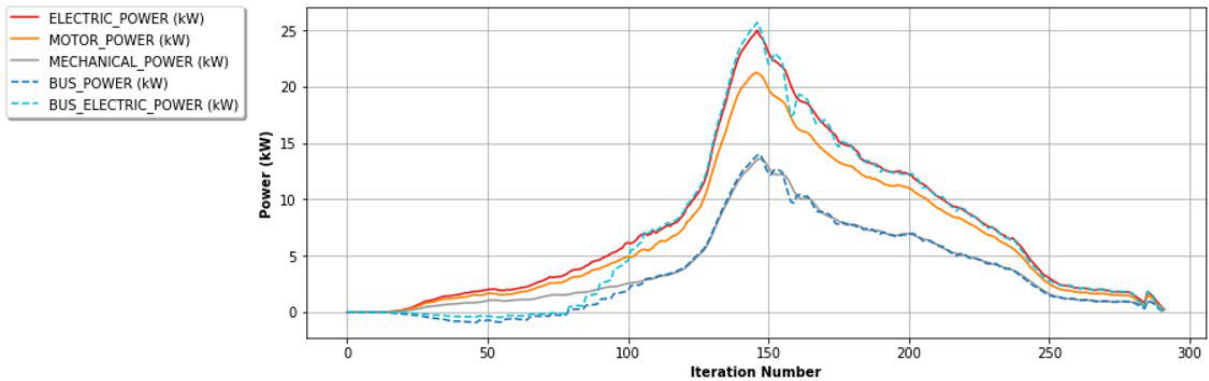
Figure 11. Calculated and corrected powers integer route.